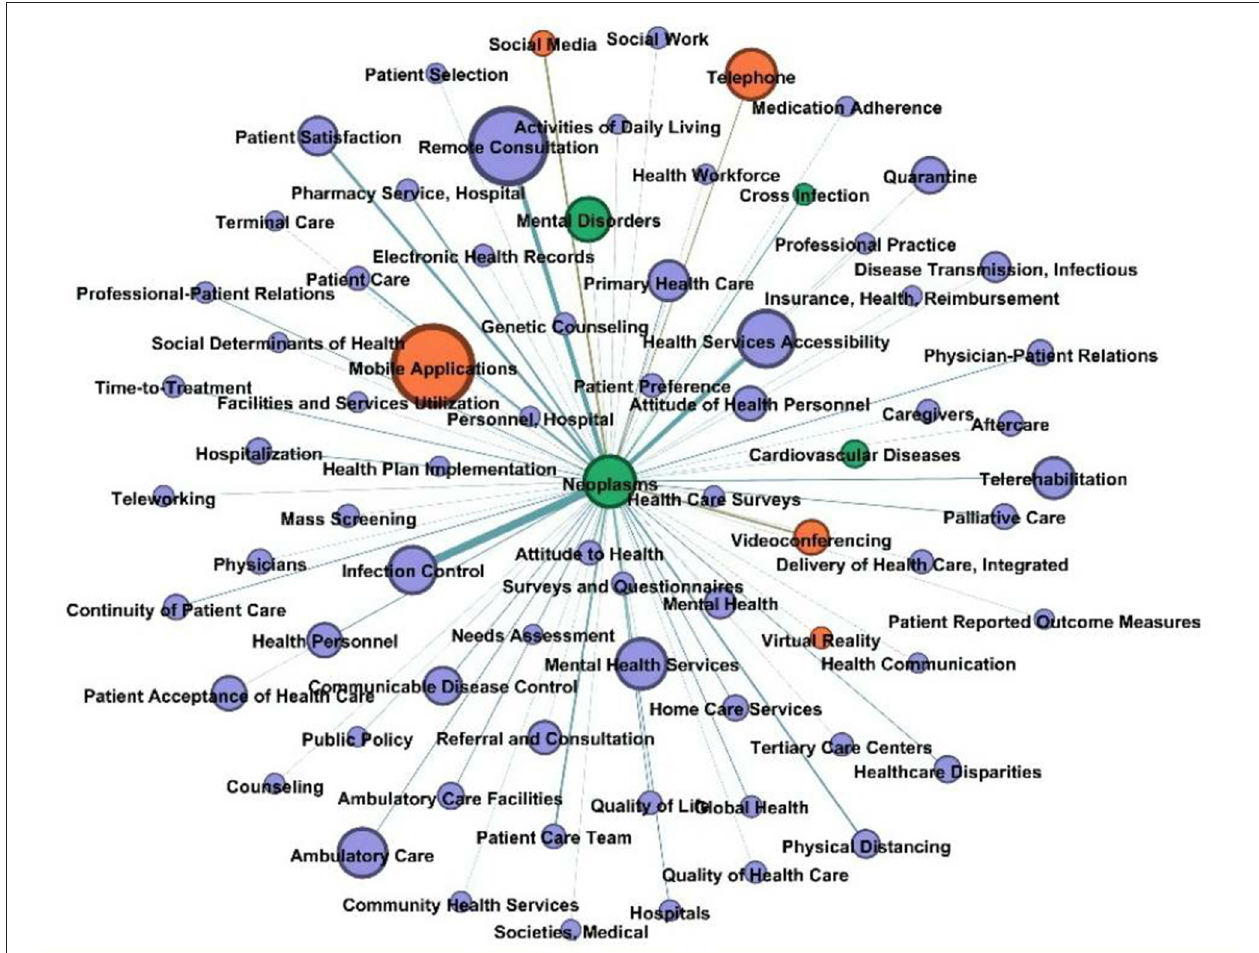
FIGURE 6 | Neoplasm node and other nodes connections in the